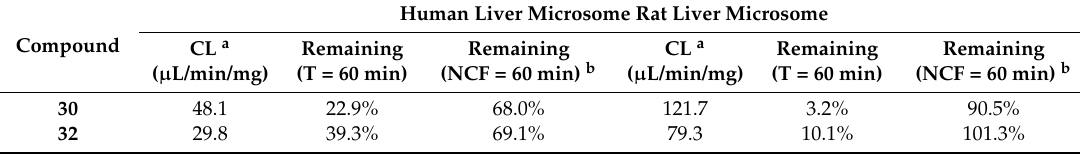
Table 3. In vitro metabolic stability study of 30 , 32 .